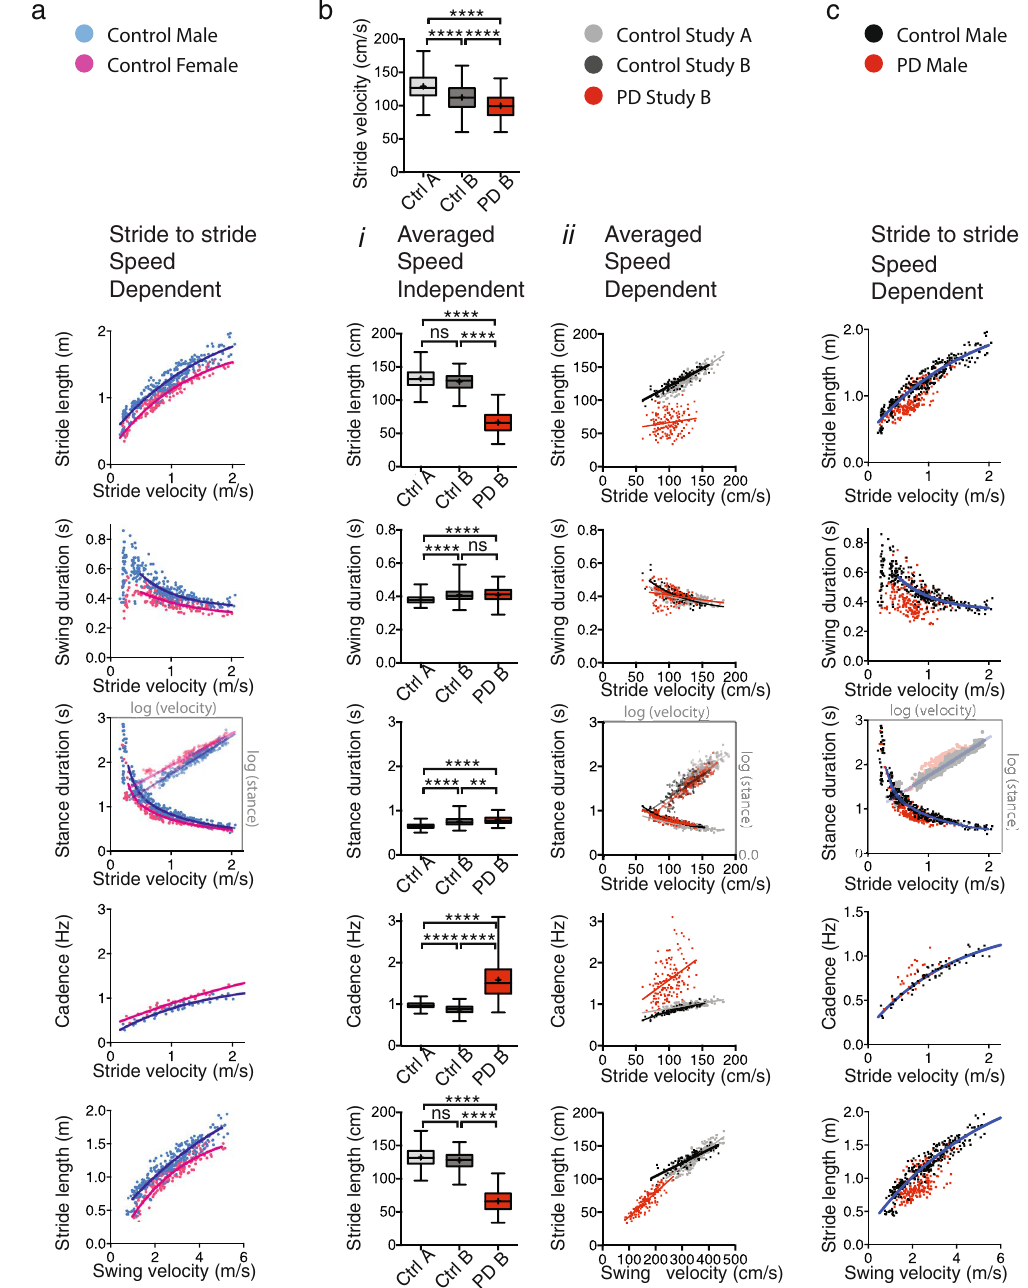
Figure 6. Gait parameters in human control subjects and subjects with Parkinson’s Disease. Spatial and temporal gait parameters depicted as a function of speed in human subjects can be represented by regression curves similar to mice, with regression curves shifting in the setting of CNS disease. ( a ) ( i-v ) : Gait parameters visualized as a function of velocity in 14 control subjects without parkinsonism or cognitive decline follow non- linear relationships. Subjects were instructed to walk at velocities ranging from very slow to very fast. Except for cadence which was based upon trial average ( iv ), data points represent stride data of the left foot. Blue represents male and pink represent female data points. Data sets were not adjusted for other biometric or demographic factors. ( b ) ( i-x ): i-v , Velocity independent stride-to-stride analysis (whisker plots; Kruskal-Wallis, followed by Dunn’s multiple comparisons test; Supplementary Table S3) shows differences among most gait parameters, which are difficult to interpret given variations in velocity among cohorts. vi-x : Data points representing trial averages (from a baseline and a slower trial) in two different cohorts of control subjects (black and gray) and in PD subjects (red) from 2 previously published studies. ( c) ( i-v ): Data points representing stride-to-stride data (from 6 trials capturing very slow to very fast speeds) in gender and age matched control subjects (black) and PD subjects (red). Asterisks indicate level of